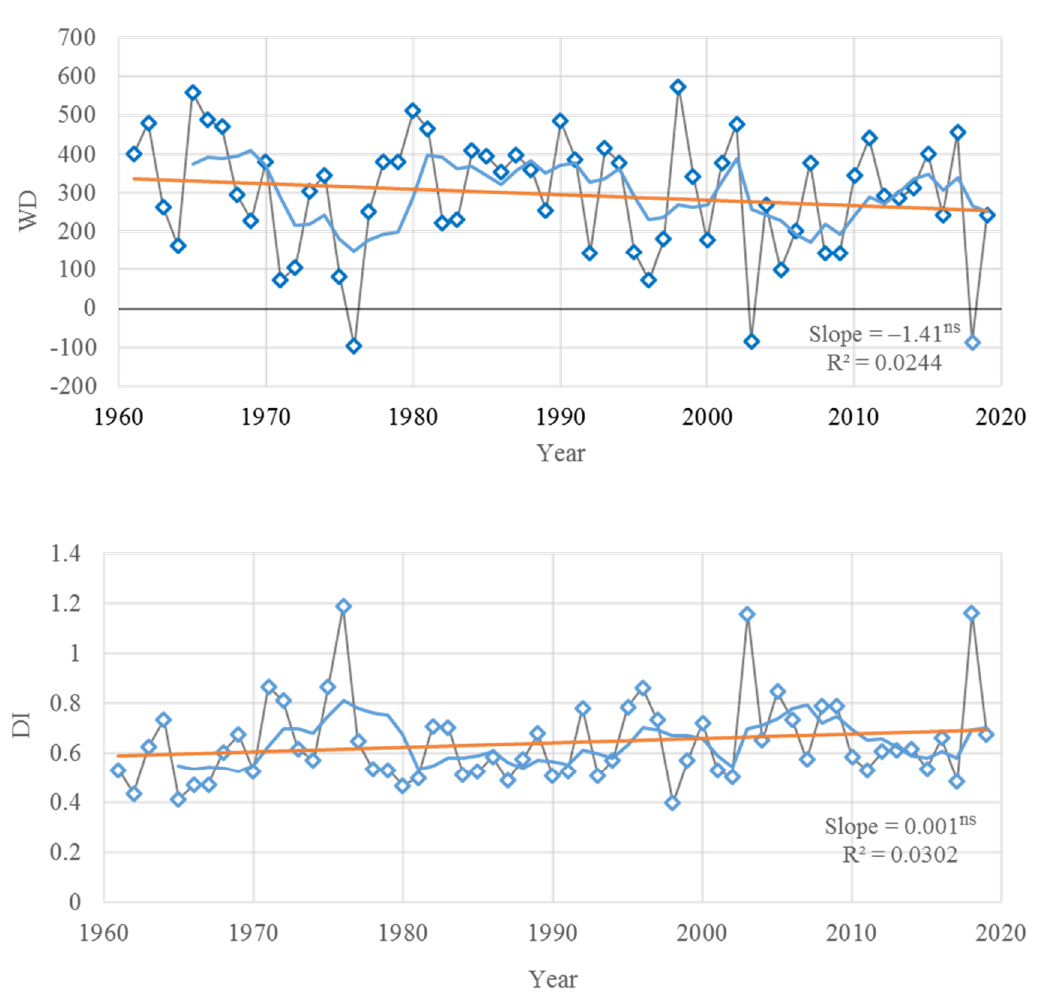
Figure 7. Time series of water deficit (WD) and dryness index (DI) for the selected synoptic station (Kiel-Holtenau). The blue line shows the 5 year moving average. The red lines denote a regression analysis. ns = not significant.